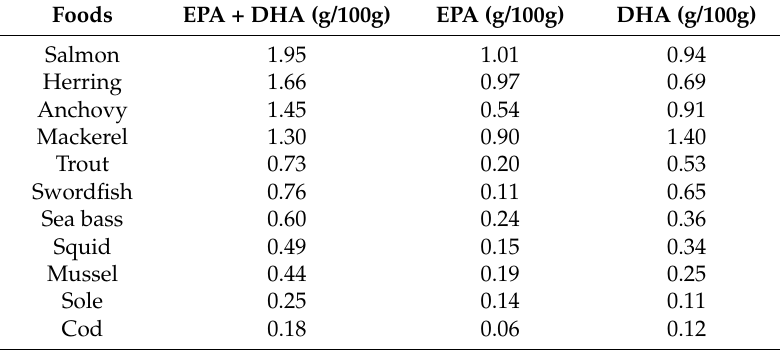
Table 1. Content of EPA + DHA and individual EPA and DHA in different fishery products [23].